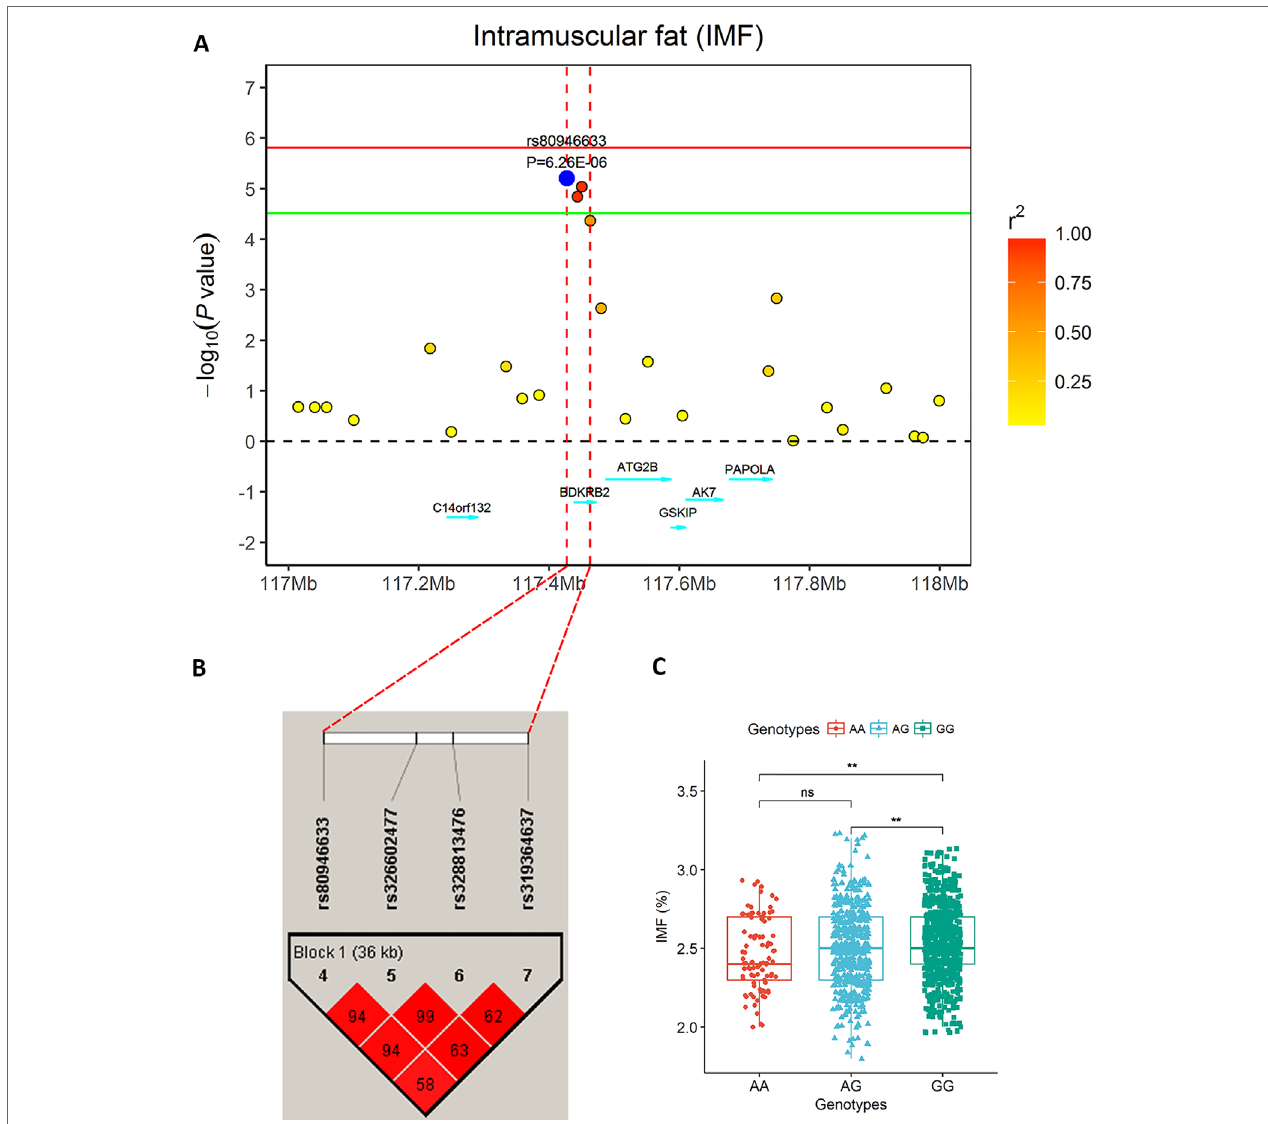
FIGURE 2 | The significantly associated region for IMF on SSC7. (A) Regional plot of a 1 Mb region around the most significant SNP (rs80946633). The circular points represent the association significance measured by -log10 ( P -values) that are plotted against genomic positions on the x-axis. Different colors indicate different linkage disequilibrium (LD) values between the top single nucleotide polymorphism (SNP) and other SNPs. (B) Haplotype blocks for significant SNPs indicate a haplotype block composed of significant SNPs located on SSC7 for the IMF trait. A haplotype block of 36 kb harbors the top SNP indicated in red and is highlighted by a black triangle. (C) The genotype effect plot of SNP rs80946633 (** P < 0.01, ns P > 0.05), which indicates SNPs with GG genotypes had higher IMF phenotypic values than those with genotypes AG and AA.